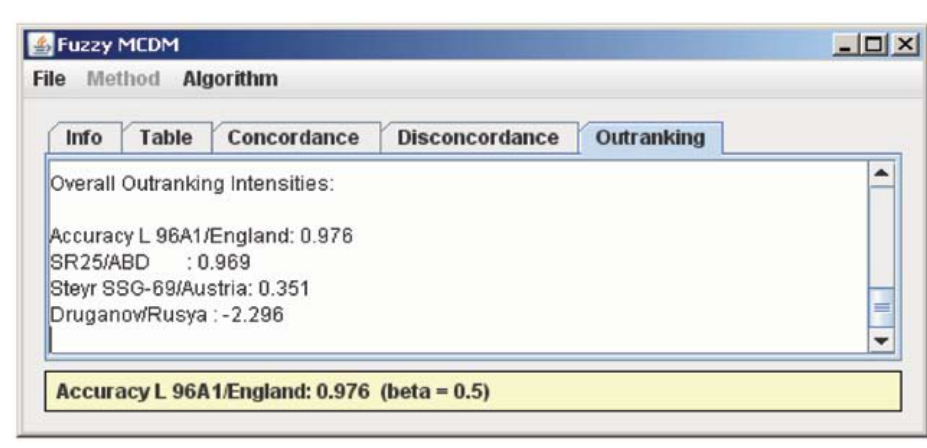
Fig. 9. Result of the sniper gun selection Table 4. The effect of changing β on overall outranking intensities = <0.4, 0.5, 0.6>